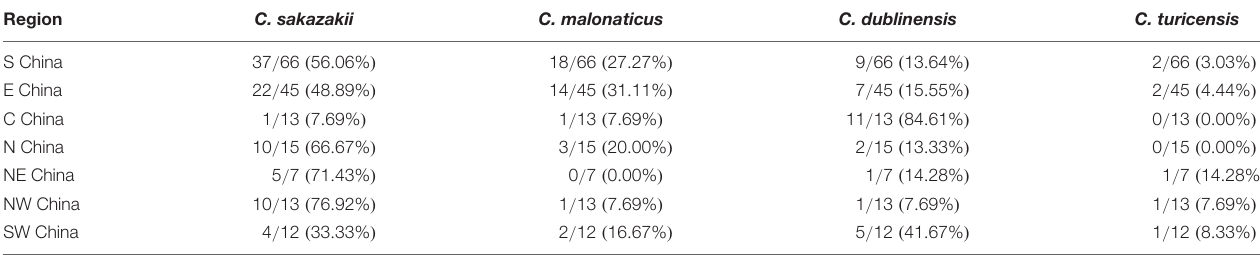
TABLE 3 | The distribution of Cronobacter species in seven geographical divisions of China. Region